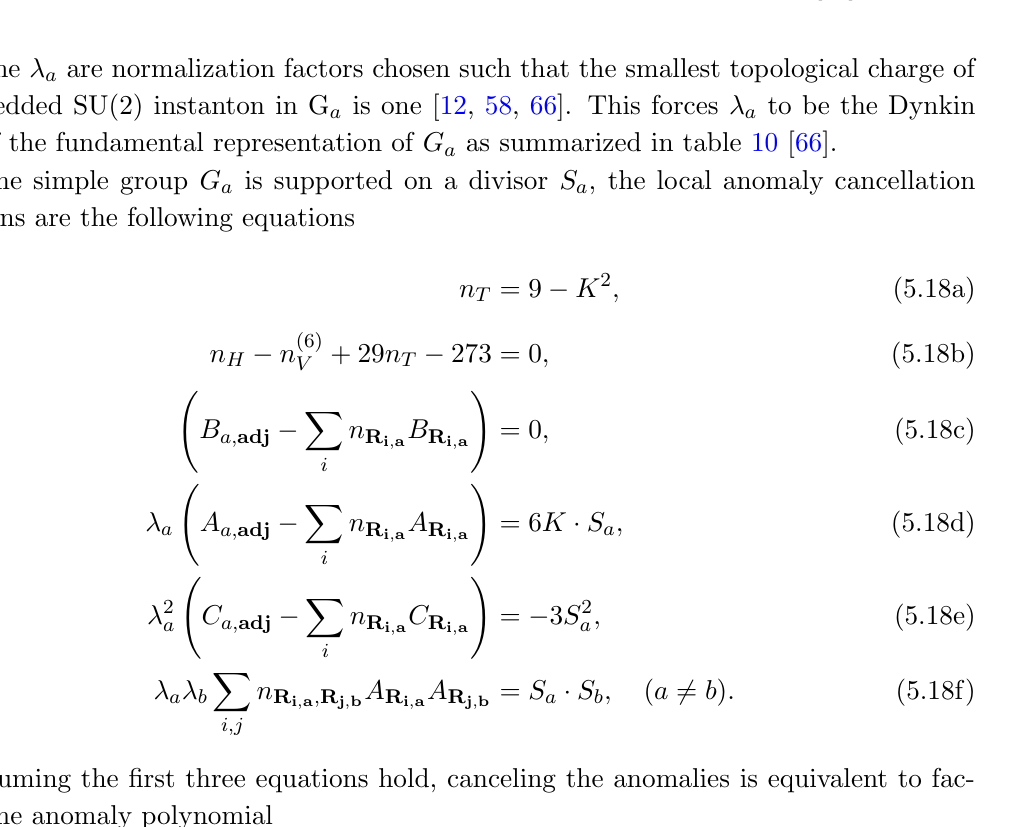
Table 10 . The normalization factors for each simple gauge algebra. See